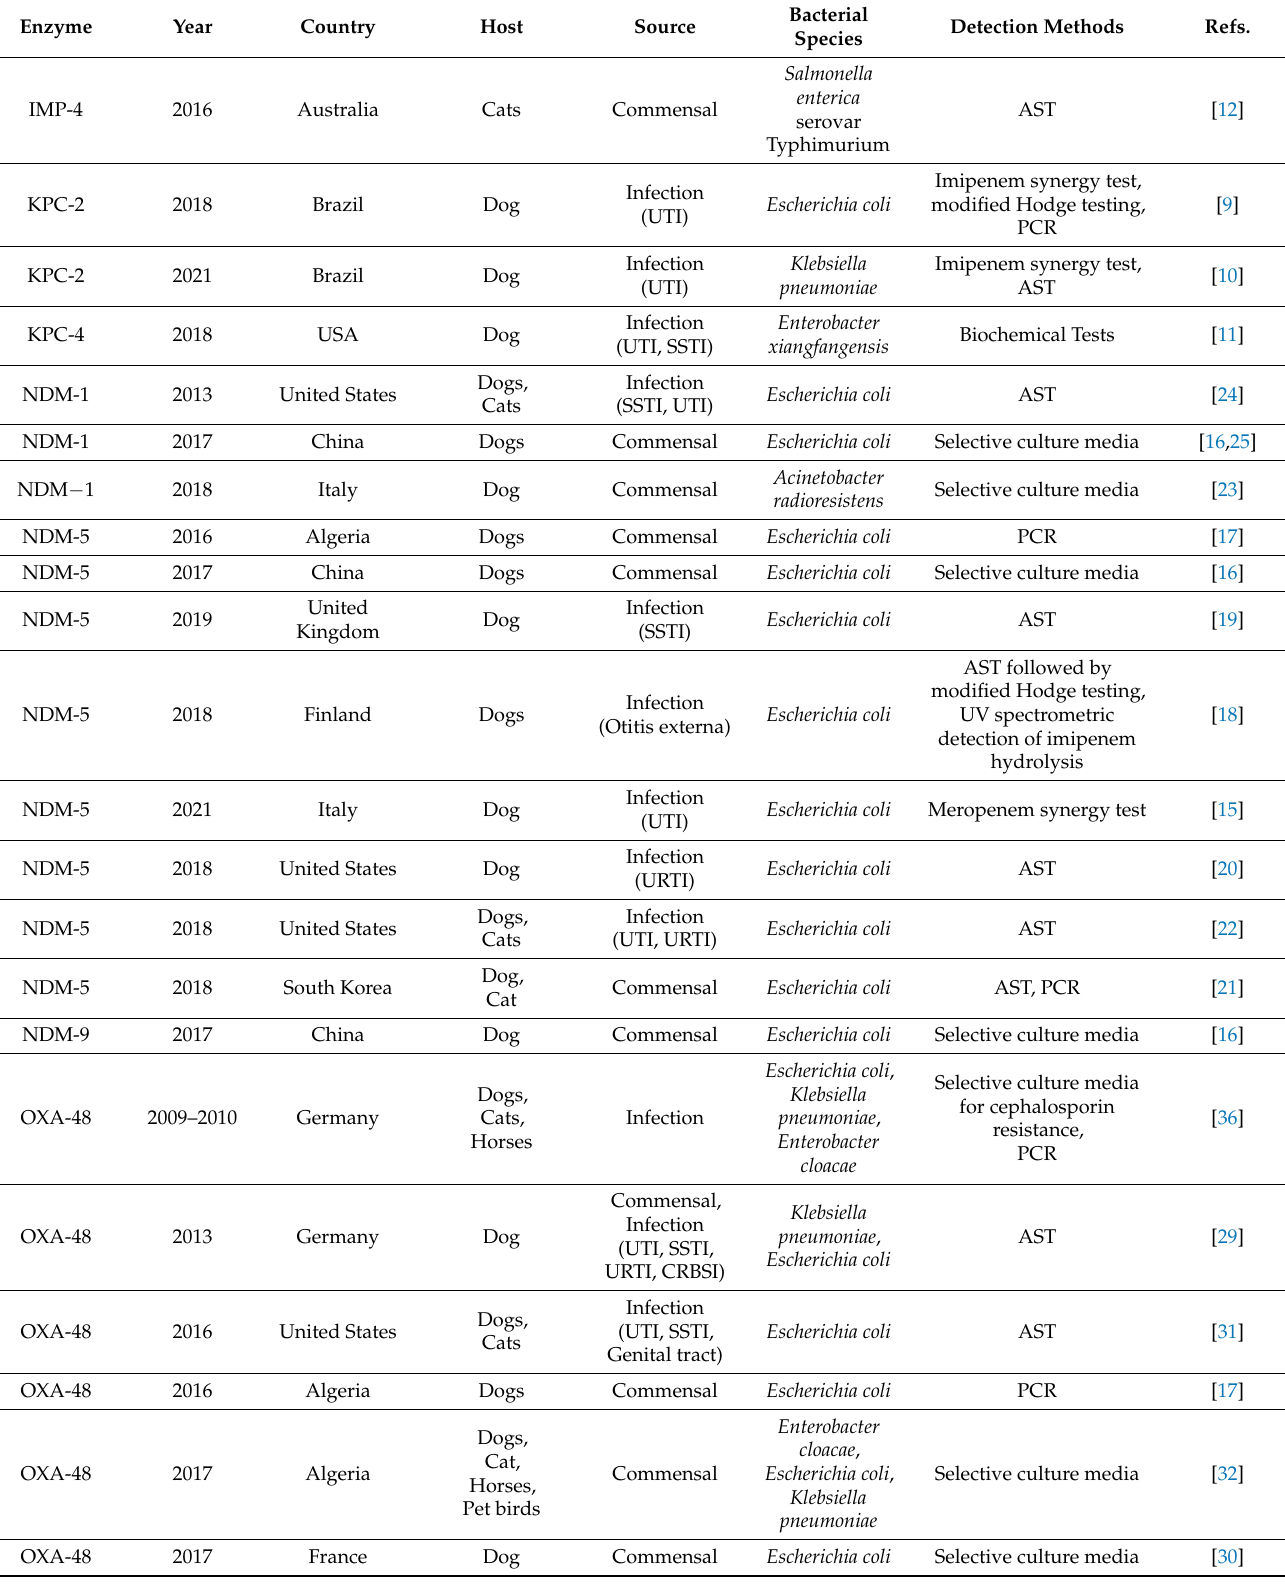
Table 1. Carbapenemases found in companion animals across the